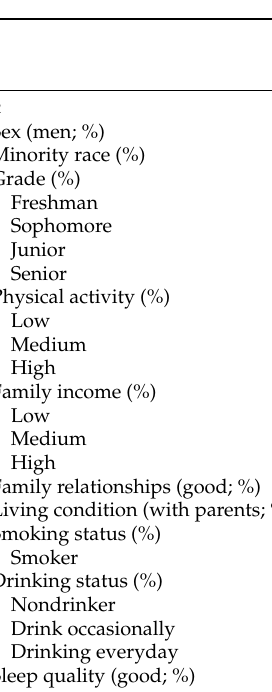
Table 1. Participant characteristics according to